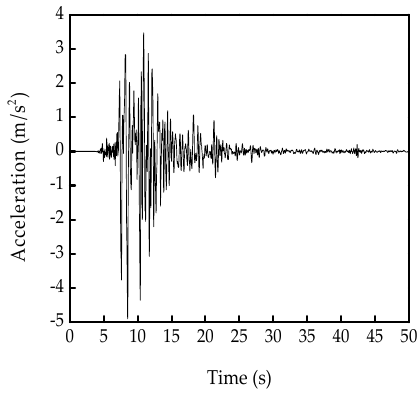
Figure 2. The Hanshin earthquake wave.